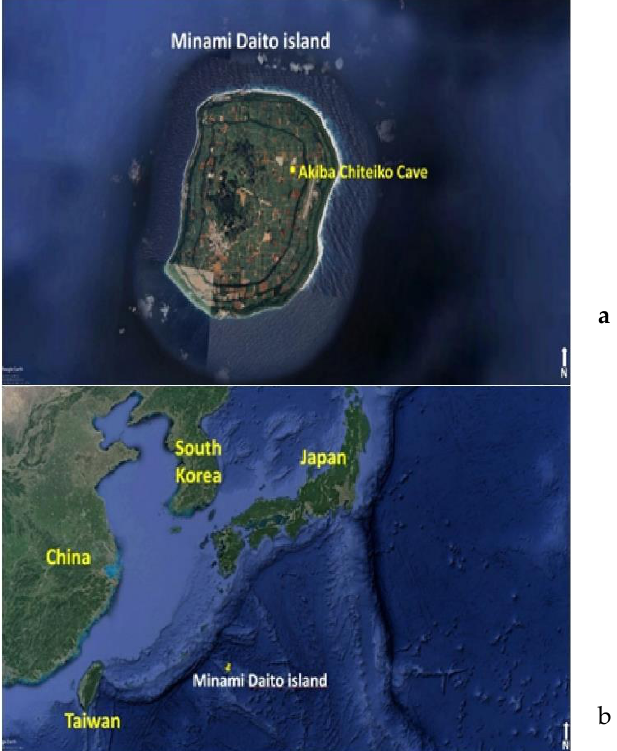
Figure 3. Minami Daito island (Japan) in relation to surrounding geography ( a ) and at a smaller scale ( b ). Specific information (latitude, longitude, sampling de1pths, dating method, ages) is reported in Table 1.